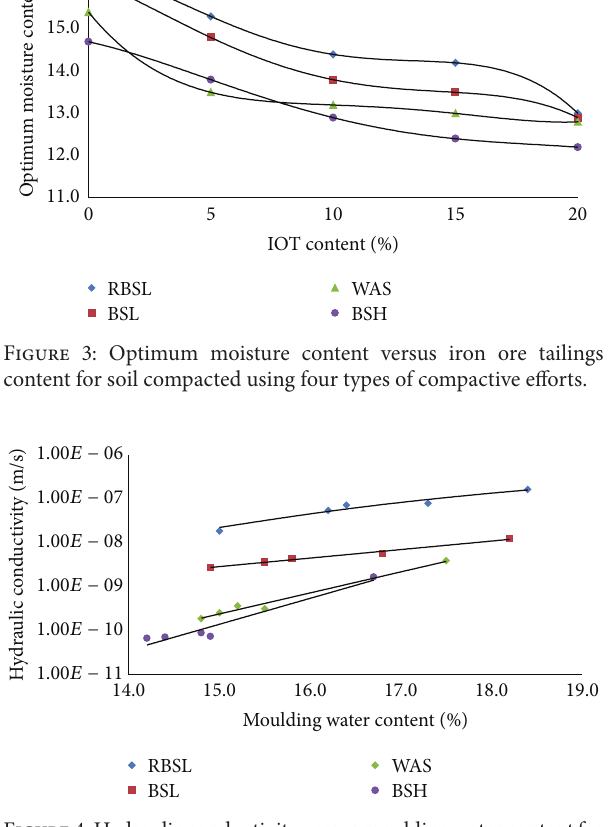
Figure4:Hydraulicconductivityversusmouldingwatercontentfor soil permeated with deionized water.